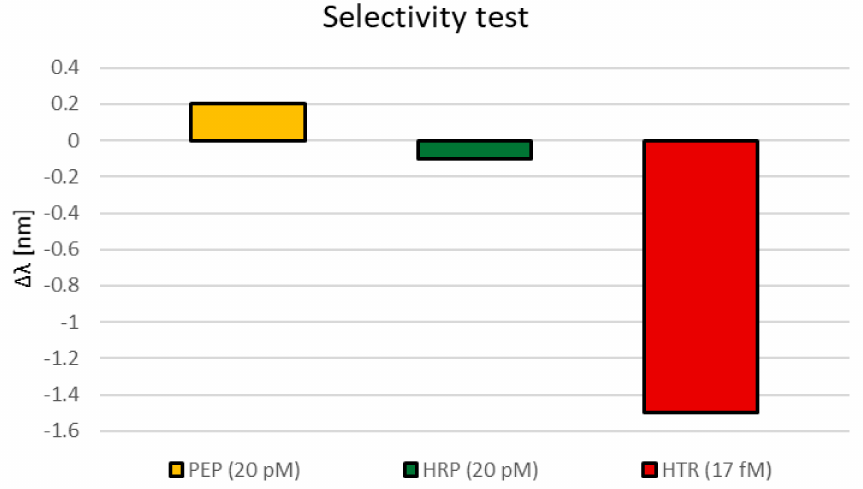
Figure 6. Resonance wavelength variation with respect to blank for different substances.